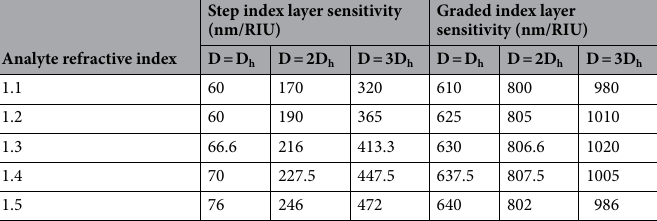
Analyte refractive